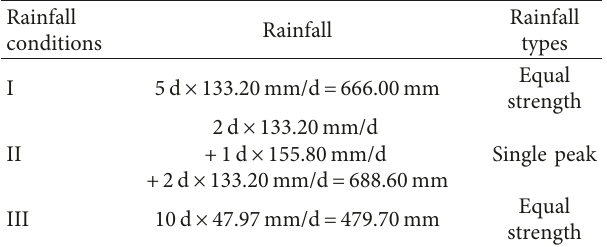
Figure 9: Calculation model. Table 5: Three rainfall conditions selected by model